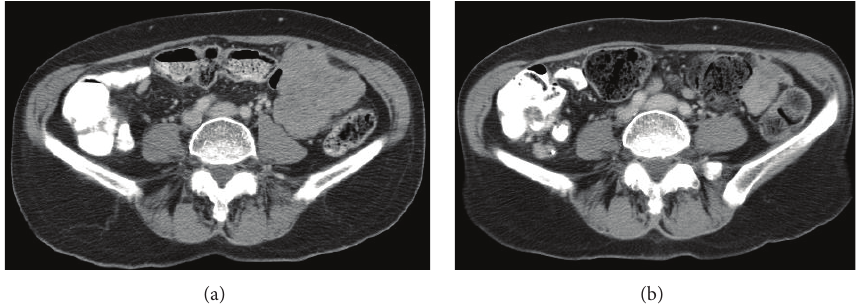
Figure 1: The figure shows the dramatic response of metastatic urethral cancer to nanoparticle albumin-bound (nab) paclitaxel. CT scan performed before therapy (a) showed an 11.5cm metastatic mass in the left pelvis. This mass decreased to 3.5 cm after 5 months of nab- paclitaxel